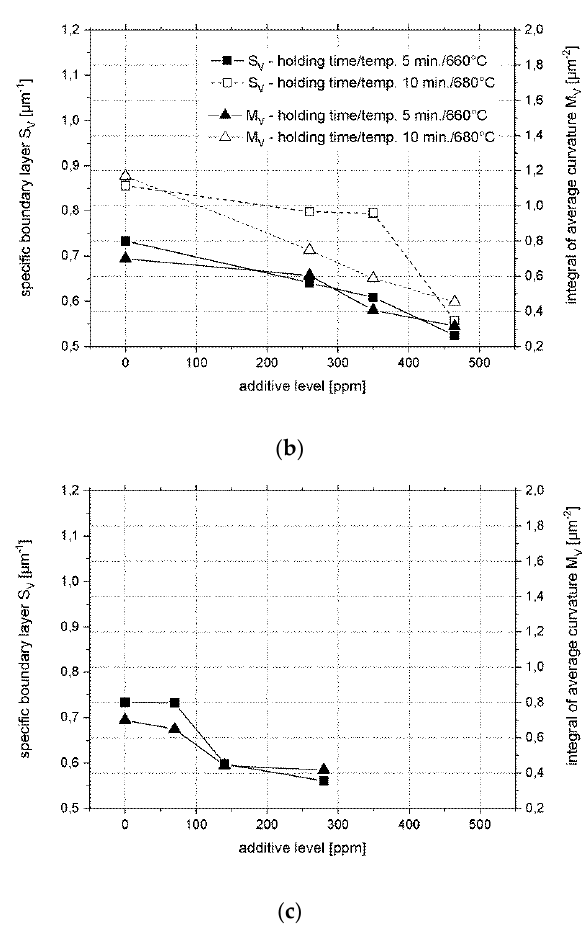
Figure 4. Influence of holding time and temperature on expression of geometrical characteristics of the eutectic phase in powder compacts after melting and resolidification, ( a ) with Sr additions, ( b ) with TiB 2 and ( c ) with B additions. Cooling is done by water quenching in all cases. For samples containing B additions, experimental data is available only for materials held for 5 min at 660 °C (series 1). The legend provided in Figure 4b refers to all diagrams.